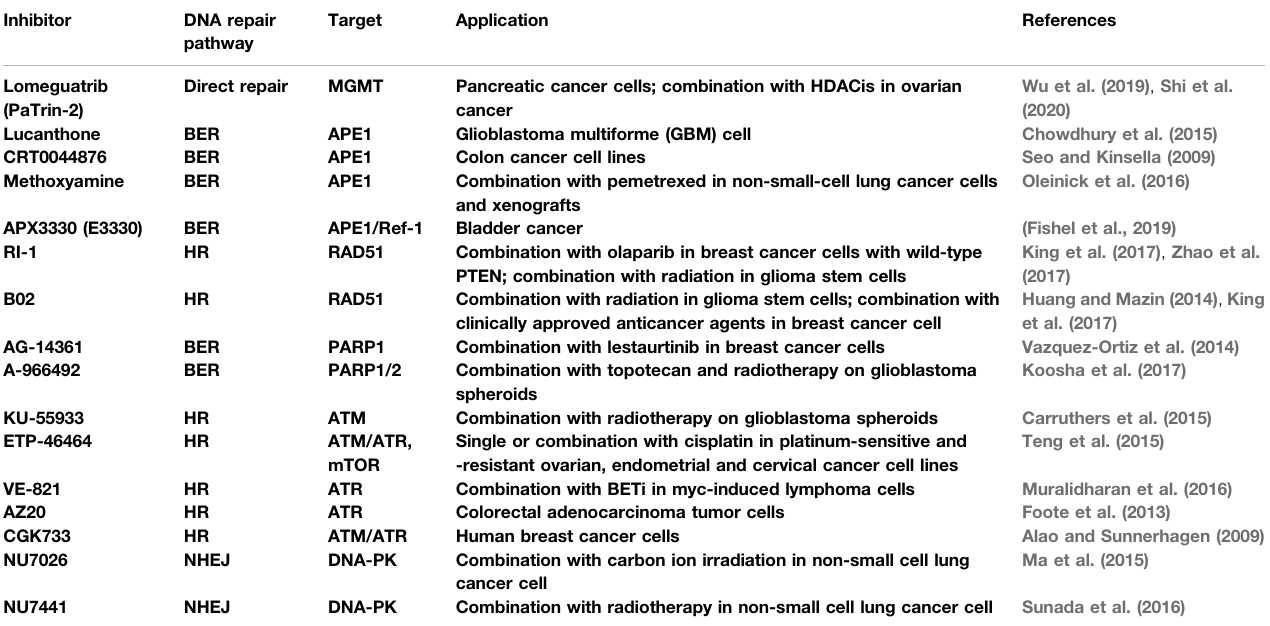
TABLE 2 | Inhibitors of DNA repair pathway recently under preclinical studies. Inhibitor DNA repair